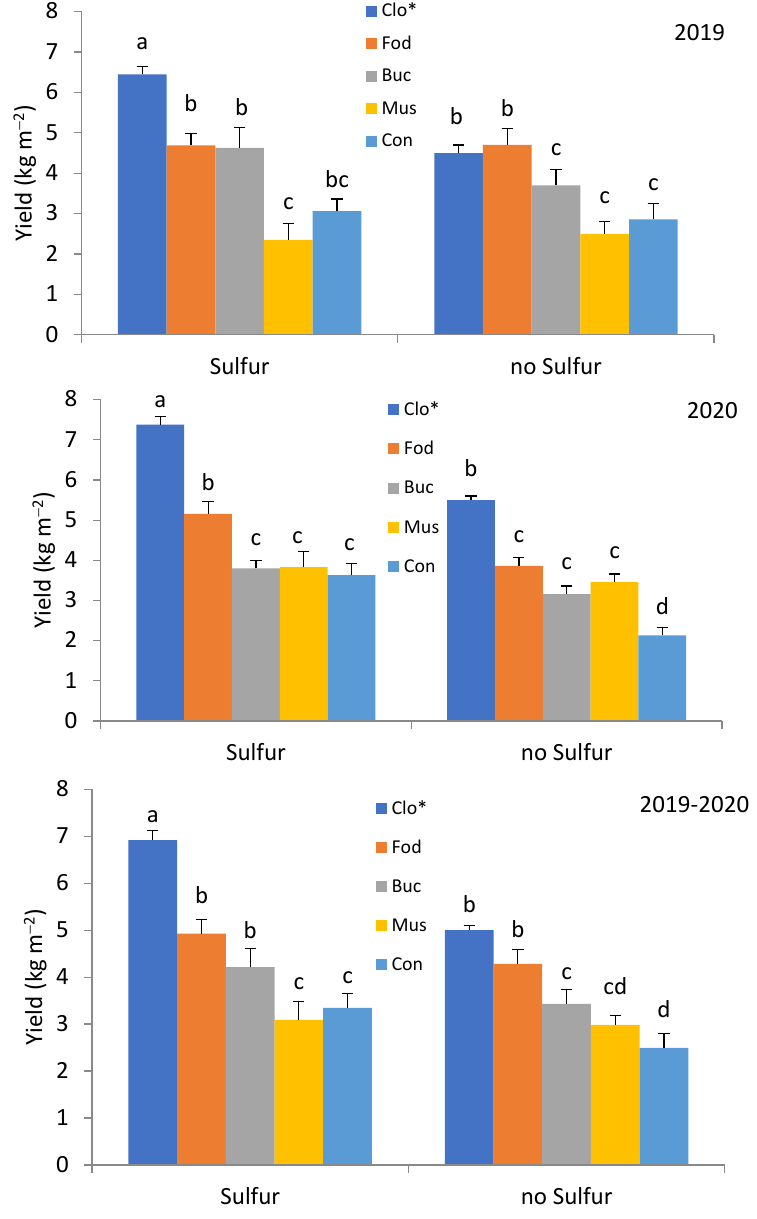
Figure 2. Yield of winter garlic cultivated under sulfur and catch crops in 2018–2020. * Clo: clover; Fod: fodder radish; Buc: buckwheat; Mus: mustard; Con: control (without cover crop); ** S: sulfur, noS: no sulfur. Different letters (a–d) indicate a significant difference between the experimental factors: sulfur × CCs; no sulfur × CCs ( p ≤